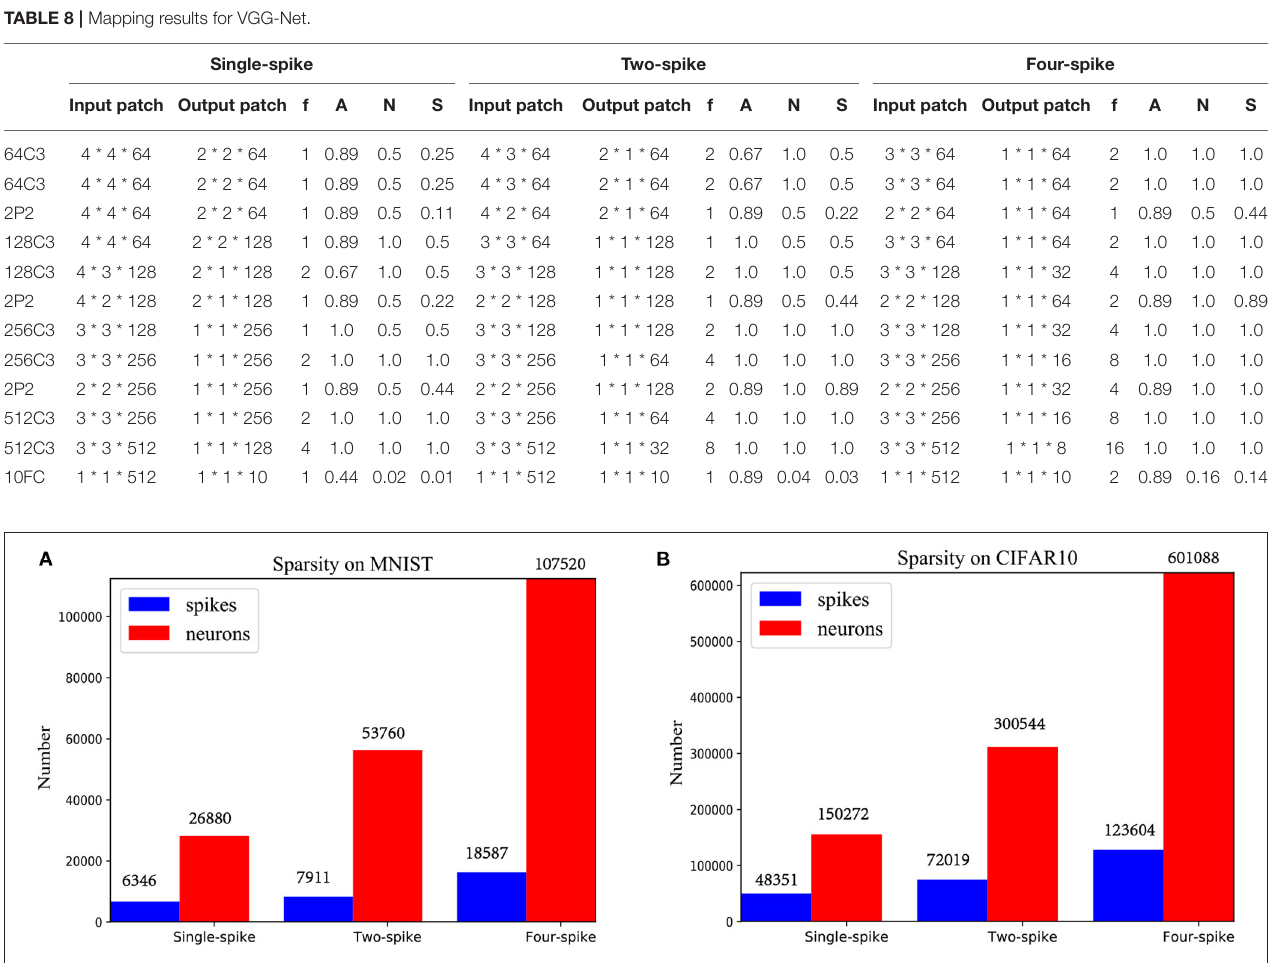
FIGURE 10 | Spiking sparsity of spiking LeNet (A) and VGG-Net (B) with different precisions.